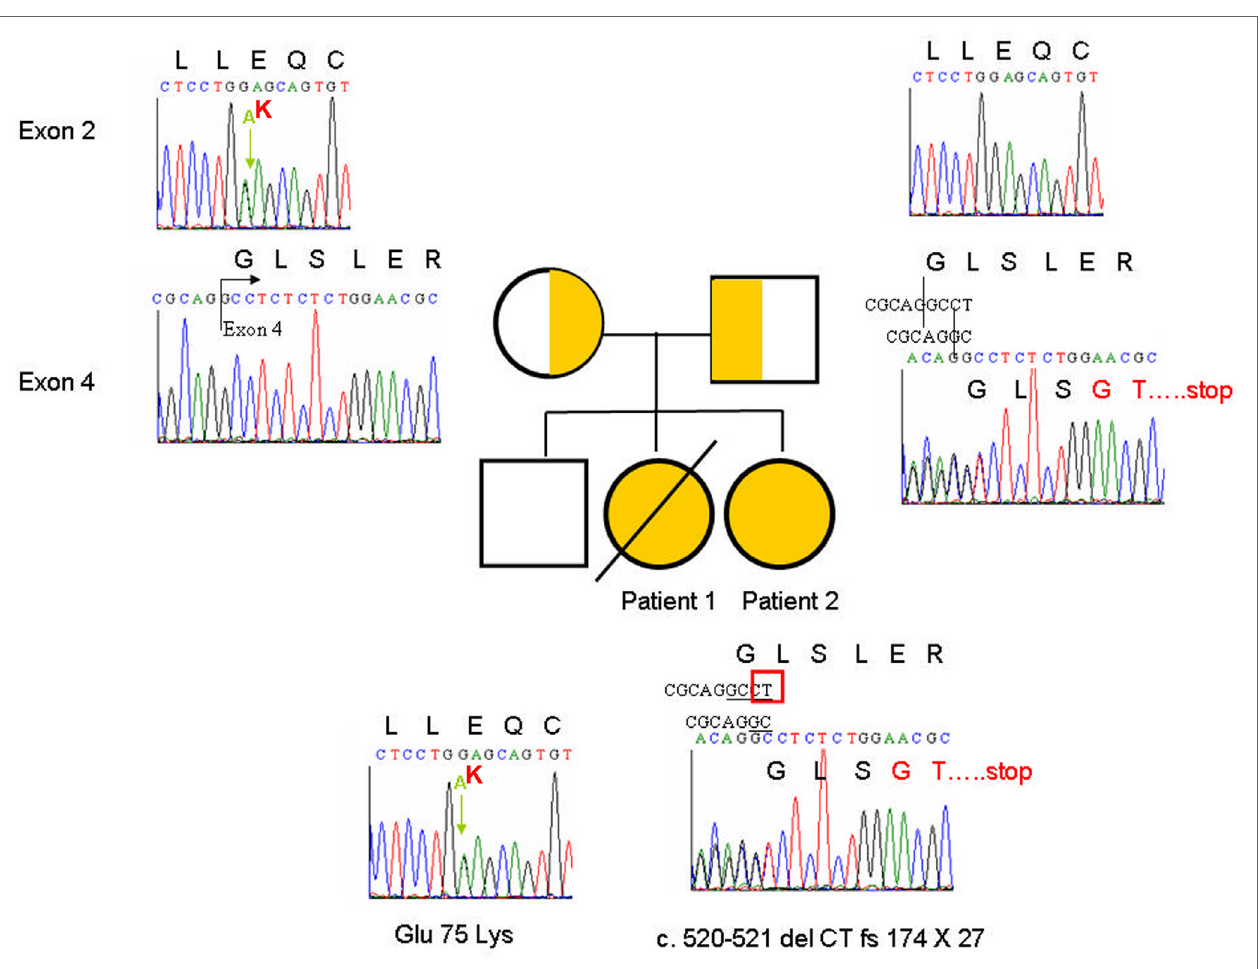
FigUre 4 | Sanger sequencing showed the heterozygous compound tetratricopeptide repeat domain 7A mutation: c.223 G > A in exon 2 causing Glu75Lys from the maternal allele and c.520-521 del CT fs174 × 27 in exon 4 from the paternal